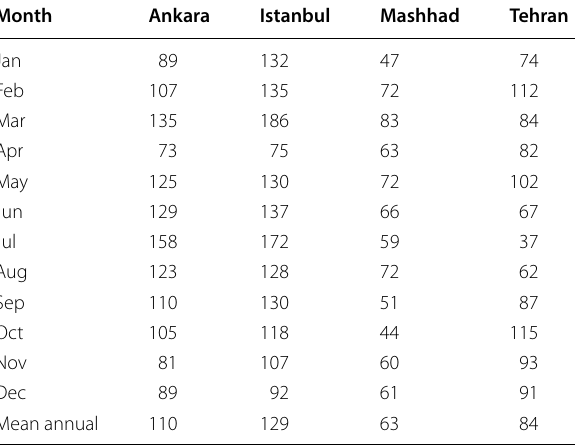
Table 3 The monthly summarized of the SWEAT